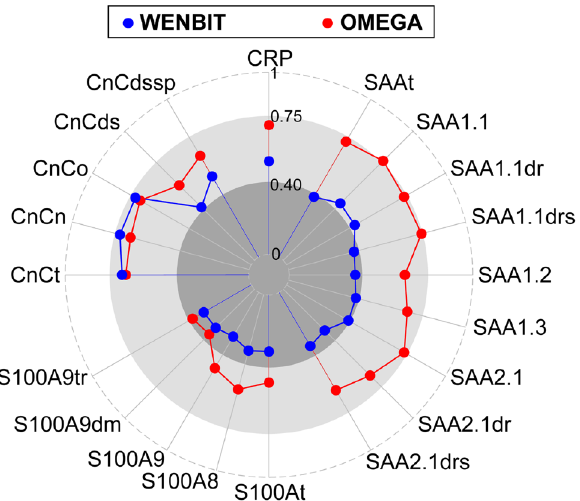
Figure 2. Comparison of intraclass correlation coefficients (ICCs) in WENBIT and OMEGA. ICCs were calculated using ln-transformed analyte values. Higher ICCs were obtained for CRP, SAA, S100A8/9 and the proteoforms in OMEGA than WENBIT while similar reproducibility was obtained for CnC and its proteoforms. Data were taken from Tables 2 and 3. Thresholds of ICCs (< 0.4: poor; 0.4–0.75: fair to good; > 0.75: excellent) were marked by different tones of grey.